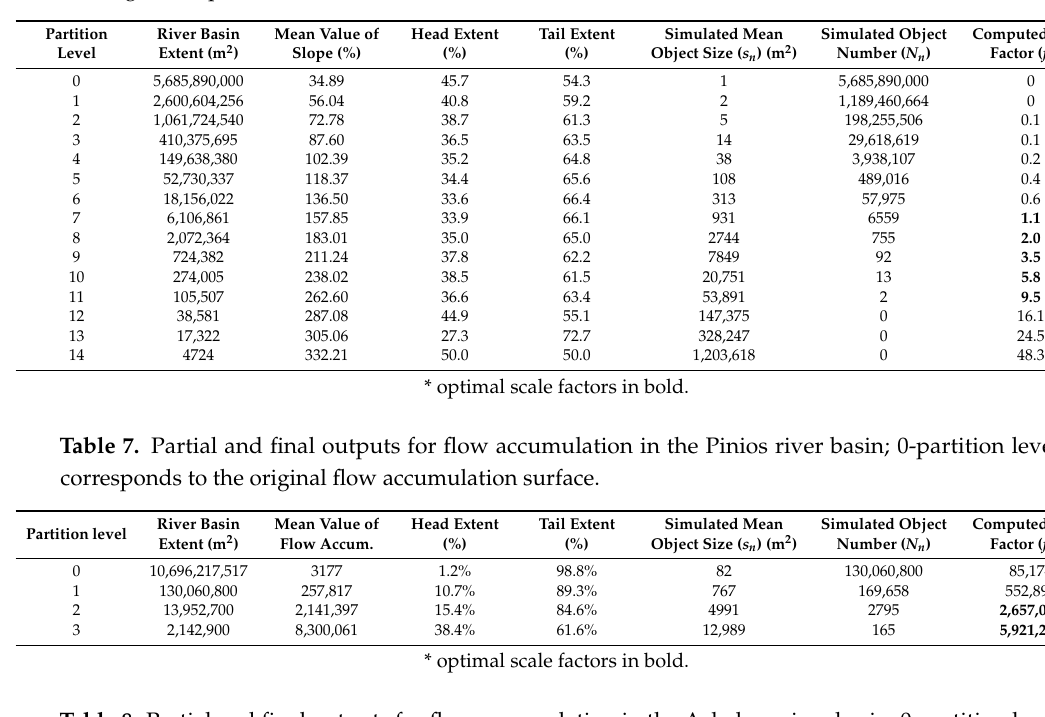
* optimal scale factors in bold. Table 6. Partial and final outputs for slope in the Acheloos river basin; 0-partition level corresponds to the original slope surface.